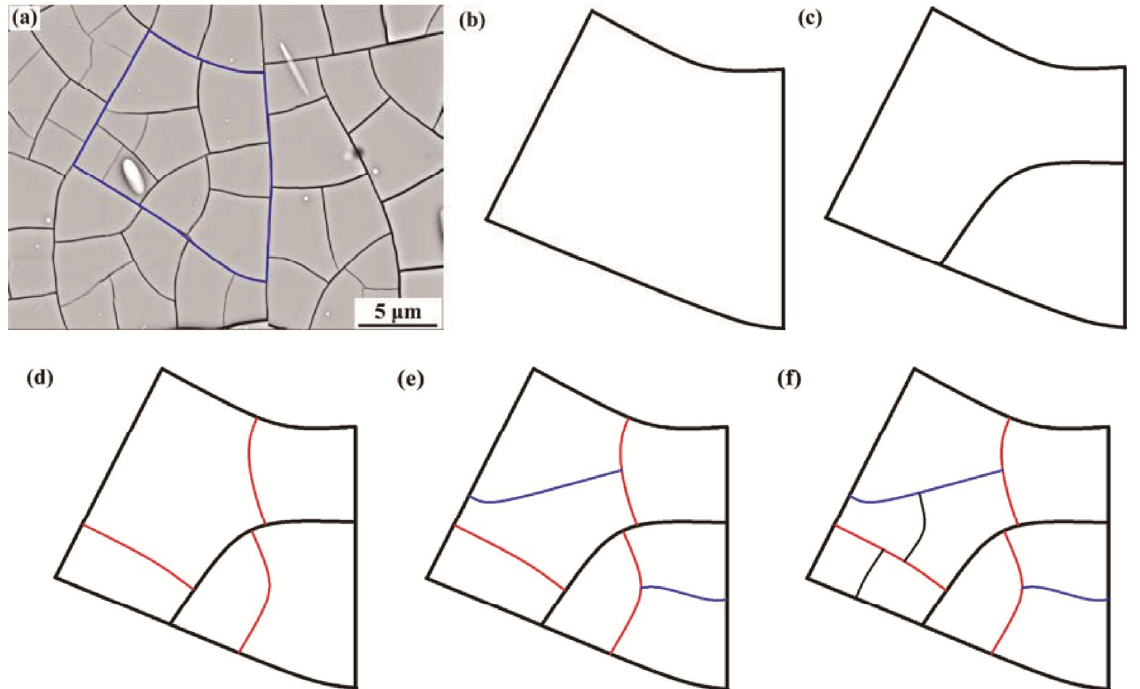
Fig. 20 Propagation from large to small scale. As the crack driving force develops, the crack patterns in (a) the selected domain evolve from (b) to (f). The crack orders from (c) to (f) are the first (bold black line), second (red lines), third (blue lines), and fourth orders (fine black lines), respectively. Reproduced with permission from Ref. [116], © ASM International